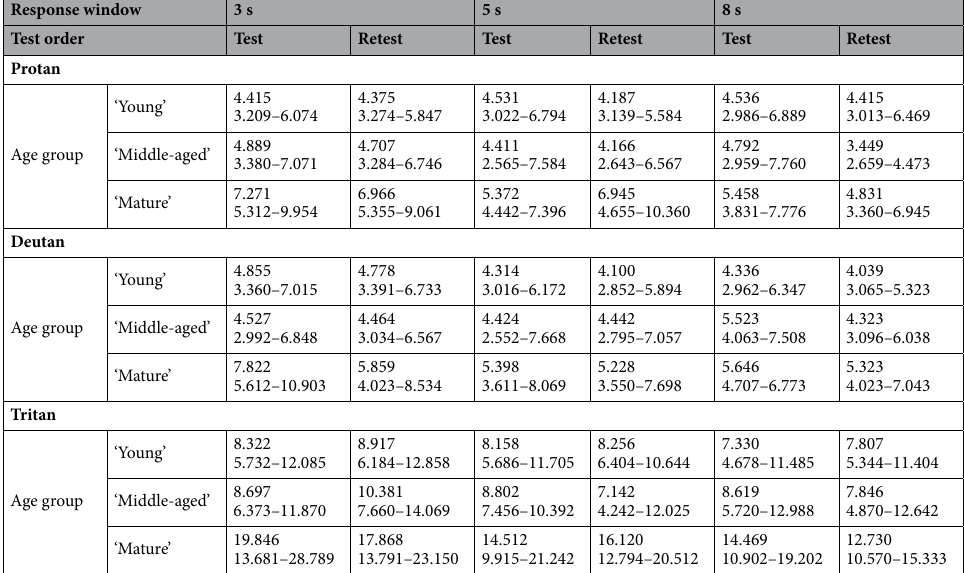
Table 2. Mean and CIs of Trivector thresholds (10 –5 u ′ v ′ units) for 3-s, 5-s and 8-s response windows, for test and retest, for participants of each of the three age groups: ‘young’ (N = 19), ‘middle-aged’ (N = 6) and ‘mature’ (N = 5). Log-transformation of raw data was used for calculation means and CIs, with the following back- transformation to u ′ v ′ units presented